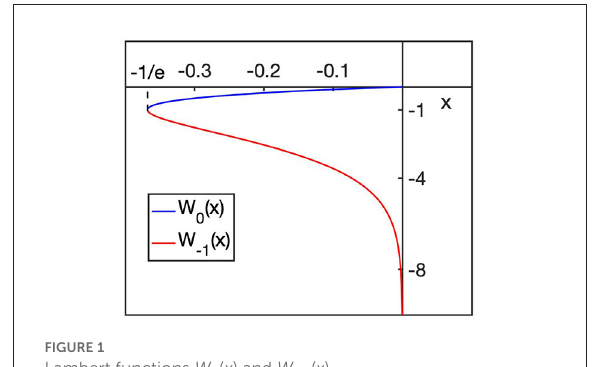
FIGURE1 Lambert functions W 0 ( x ) and W − 1 ( x ).